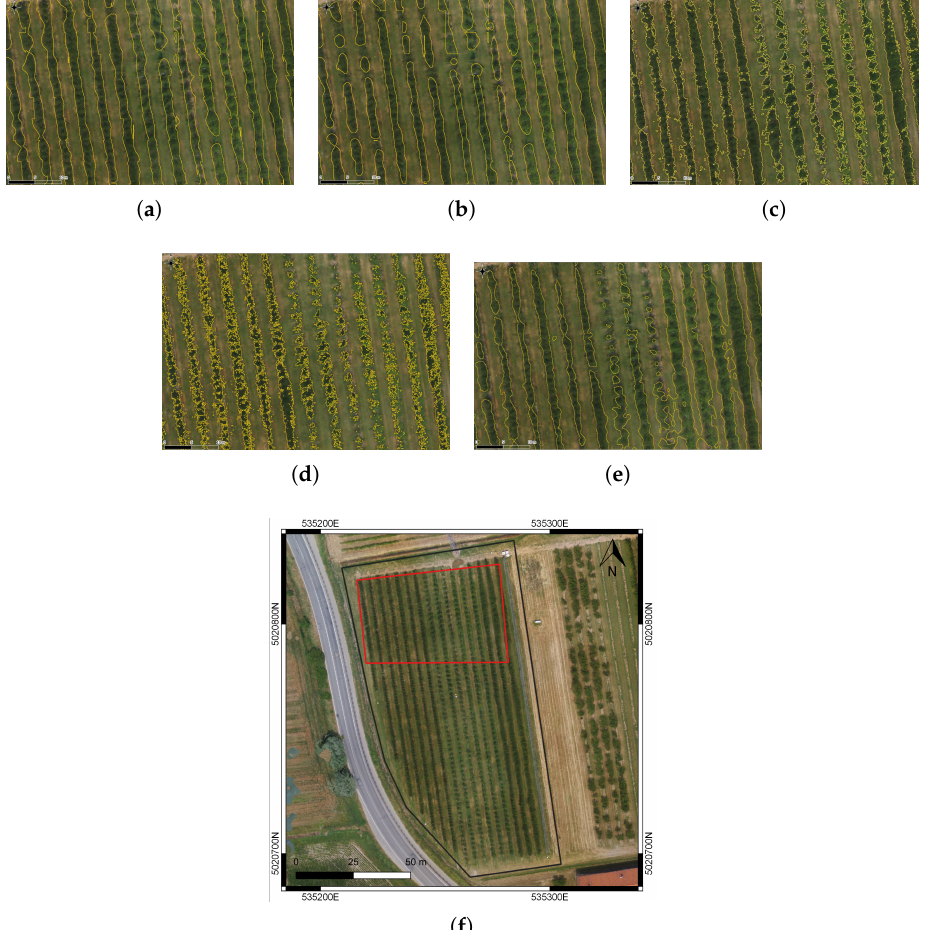
Figure 9. Pear orchard site: crop row detection results for ( a ) local maxima extraction, ( b ) threshold selection, K-means clustering ( c ), MDM classifier ( d ), and Bayesian segmentation ( e ). Figures refer to the area included in the red box in ( f ).